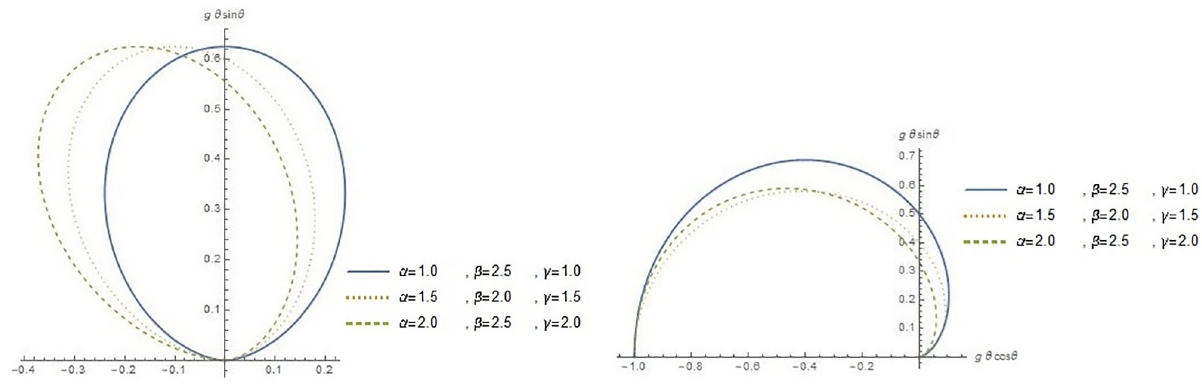
Fig 2. Circular presentation of hcMB − III distribution with its